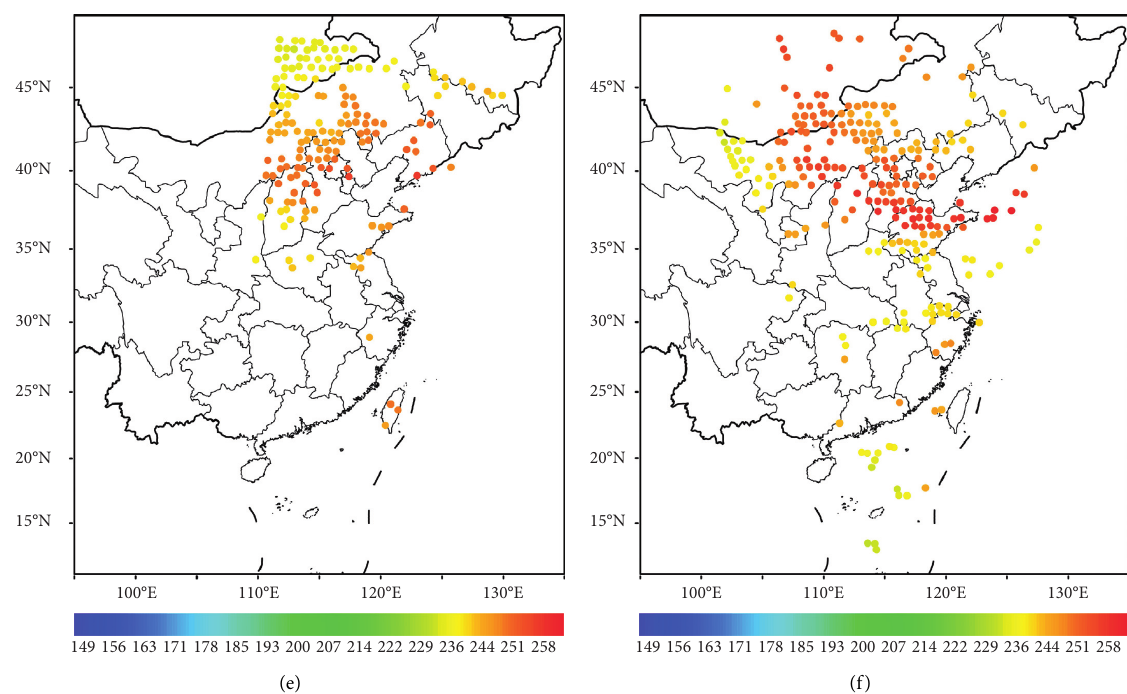
Figure 2: The distributions of the assimilated observations of channel 11 at 0000 UTC 23 June in the DY (a) and AL (b) experiments; the distributions of extra assimilated observations in the DY experiments at 0000 UTC 23 June (c), 1200 UTC 23 June (d), 0000 UTC 24 June (e), and 1200 UTC 24 June (f) (the dashed lines off the coast are the national boundaries of China over sea). Table 4: The extra assimilated observations for channels 11–15 reobtained by the emissivity retrievals at each analysis time. Channel